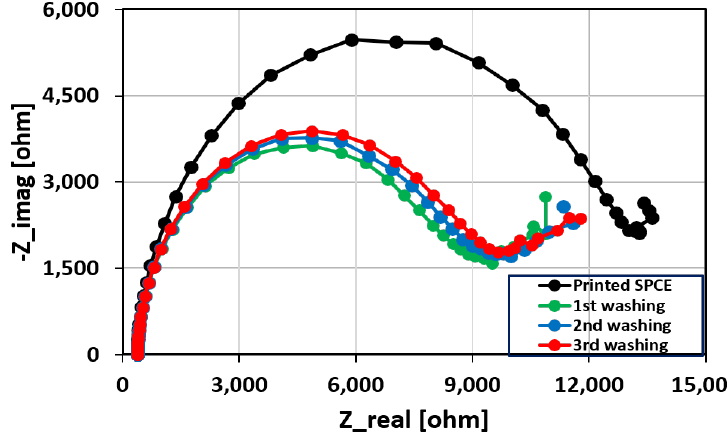
Figure 2. The effect of washing on the printed sensor. After the first wash, the R ct value obtained from the Nyquist curve drops by approximately 31%. Subsequent washes do not significantly change the radius of the Nyquist curves, suggesting that the remaining aptamers are securely attached to the CNTs.